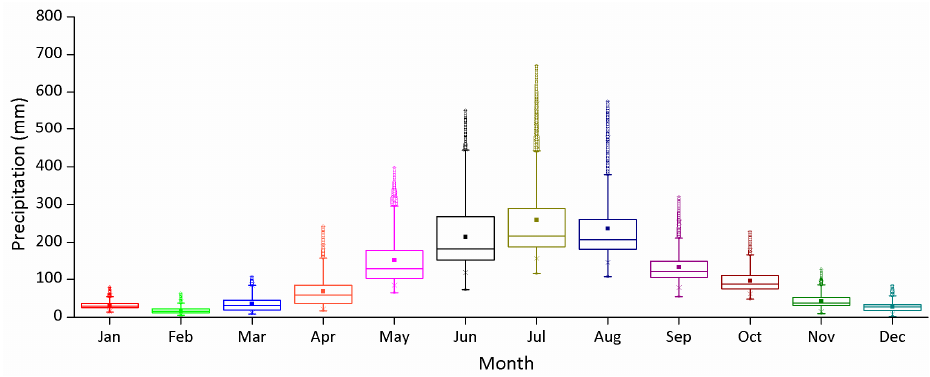
Figure 12. Box plots of downscaled average monthly precipitation during 2001–2015. The measurements from validation RGS were also used to assess the accuracy of the downscaled monthly data. The 19 validation RGS were the same as those mentioned in Section 3.3.2. Figure 13a,b compares the monthly precipitation from RGS with the corresponding values from the original TRMM 3B43 data and the downscaled data. The original TRMM 3B43 data could estimate the monthly precipitation with R 2 = 0.88, RMSE = 26.5 mm, MAE = 13.7 mm, and Bias = − 0.023. The monthly DSdis data agreed well with the measured data with an R 2 of 0.91, RMSE of 22.2 mm, MAE of 13.5 mm, and Bias of 0.048. The monthly DSdis data could improve the accuracy further with increased R 2 and reduced RMSE , but the improvement was not significant with respect to MAE and Bias . Considering the strong seasonality of precipitation in this region, the seasonal bias in the original TRMM data may be introduced into the downscaled monthly precipitation by using the monthly fraction disaggregation method. To explore the effect of the seasonal bias on the downscaled monthly precipitation, we compared monthly precipitation from RGS with the original TRMM data and the downscaled TRMM data in dry and wet seasons, respectively. Figure 13c,e show an underestimation